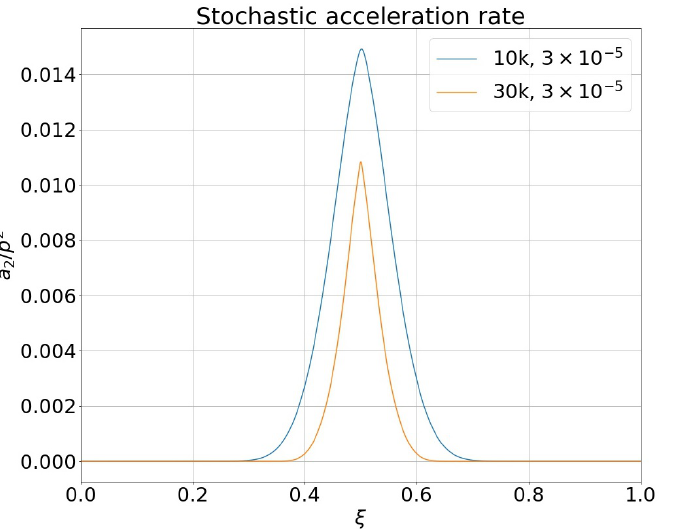
Figure 10. The calculated stochastic acceleration rate of particles for simulations of coronal loops with the sizes L = 10,000 km and L = 30,000 km. The normalization value used for both simulations is α = 3 × 10 − 5 . The longer loop has a spatial cell size ∆ x = 5 km and the smaller loop ∆ x = 20